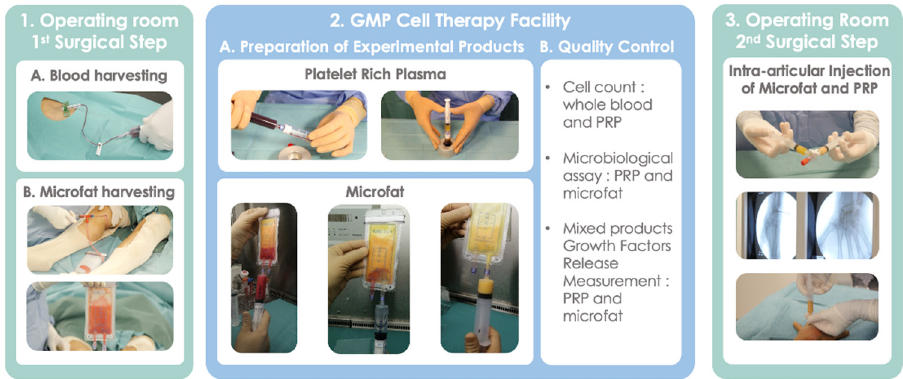
Figure 1. Procedure of preparation of experimental products: PRP and Microfat.